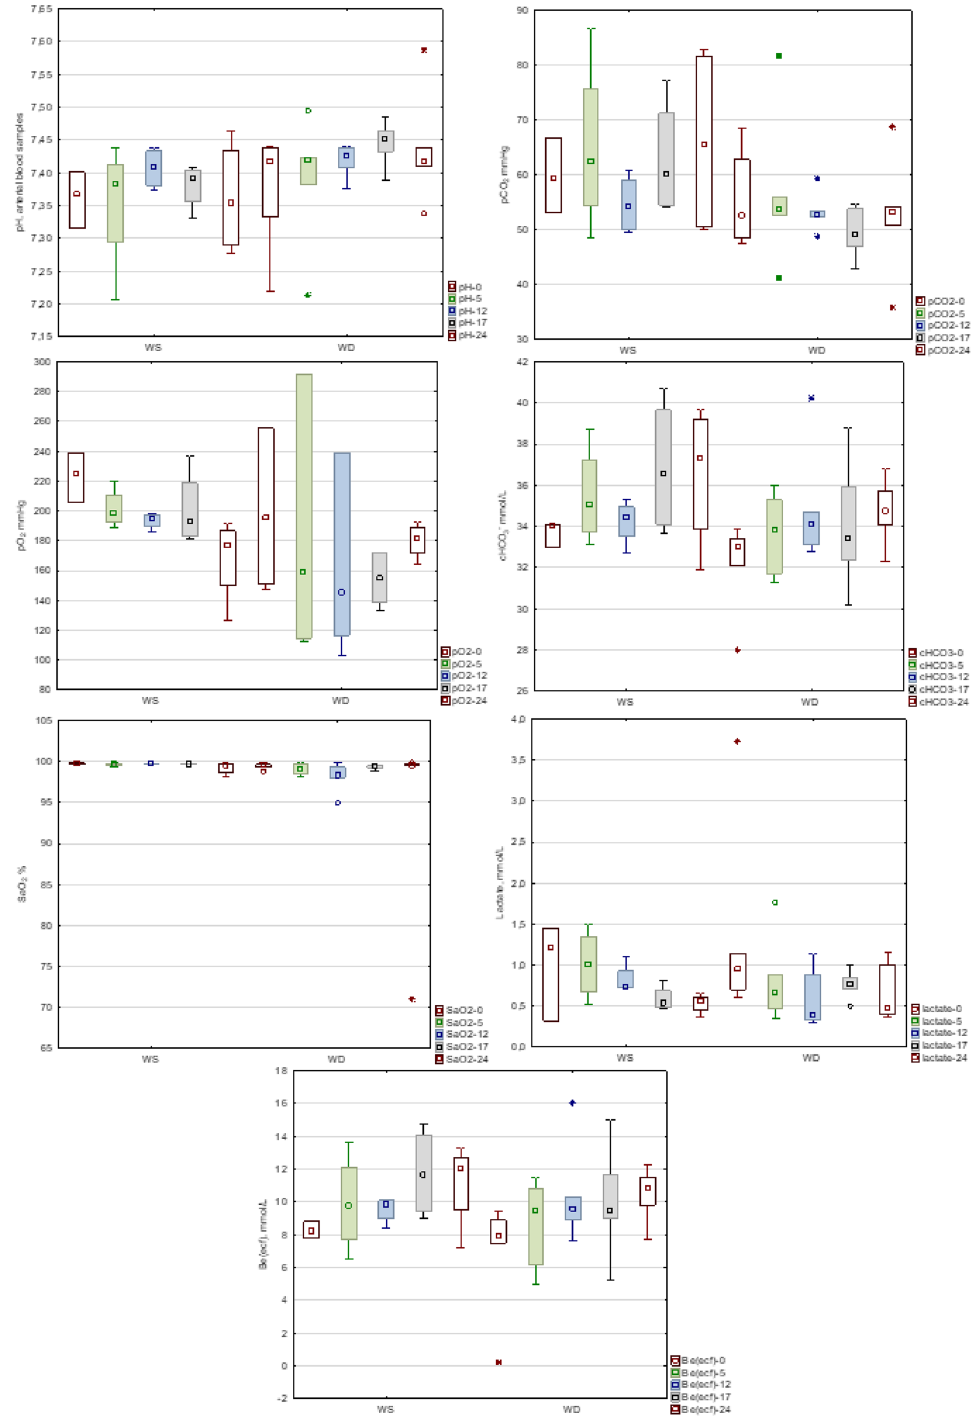
Figure 3. Arterial blood parameters were recorded at 0, 5, 12, 17 and 24 h in Experiments 1 and 2 (WS group) and Experiments 4, 5, and 6 (WD group) for ANOVA Friedman’s test. Squares indicate the median values. Boxes indicate the IQR. Whiskers indicate the nonoutlier range. Circles indicate outliers, and asterisks indicate extreme values—the values beyond the nonoutlier range. pH, The activity of hydrogen ions; pCO 2 , Carbon dioxide partial pressure; pO 2 , Oxygen partial pressure; cHCO 3− , Bicarbonate concentration; Be(ecf), Base excess in the extracellular fluid; SaO 2 , Oxygen saturation of hemoglobin; lactate, Lactate